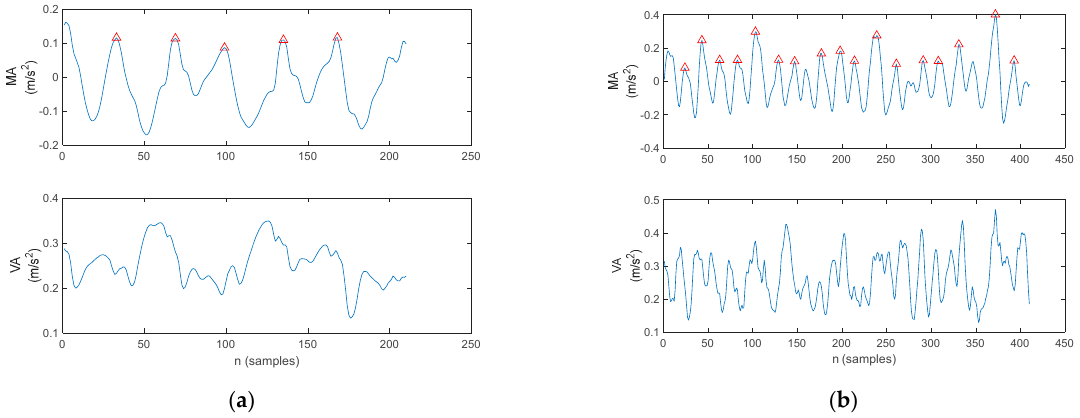
Figure 14. The arm balance MA and VA waveforms during the walking trials, with the red triangles indicating the MA maxima. ( a ) Healthy control—the MA exhibits a U-shaped variation and the VA accounts for smaller variation, and ( b ) PD patient—the MA exhibits a larger number of local peaks with reduced amplitude and the VA accounts for larger